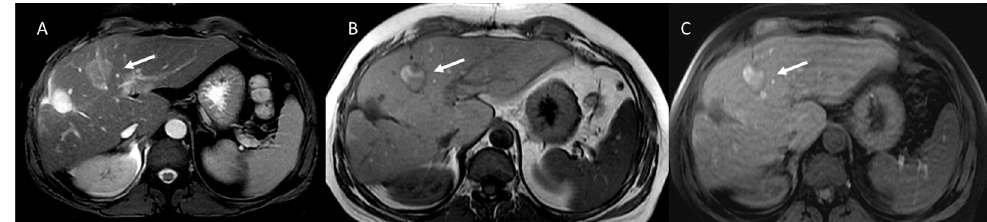
Figure 6. Liver metastasis treated with RFA. The ablated lesion is heterogeneous hyporintense on T2-weighted image ( A ) and heterogeneously hyperintense on T1-weighted images ( B ). On portal phase ( C ), the ablation zone is well demarcated with no enhancement (arrow).